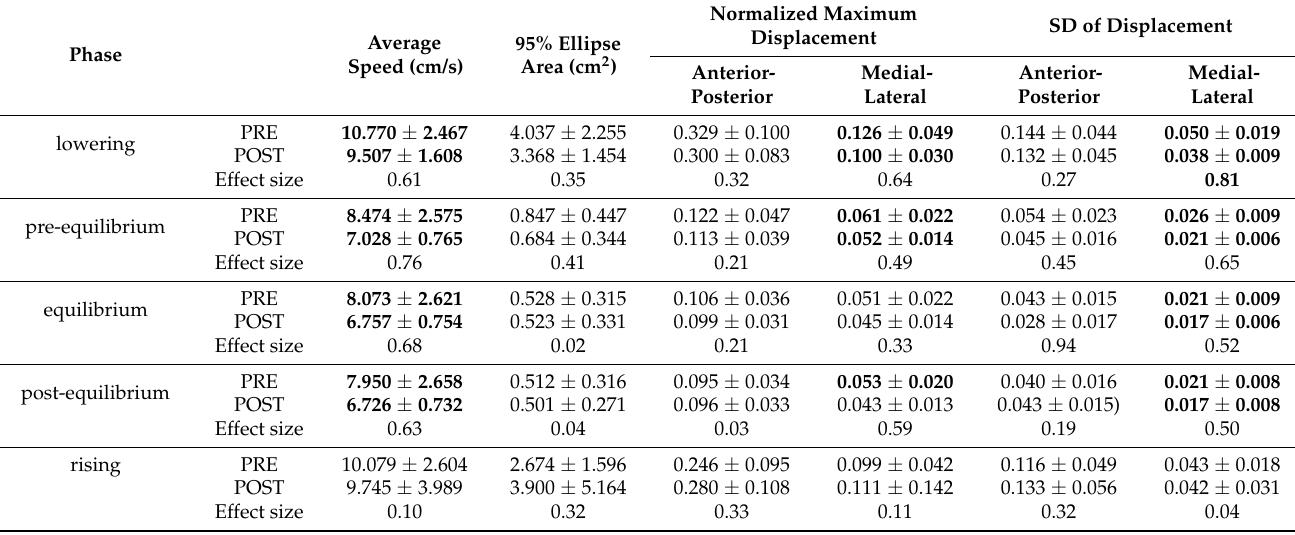
Table 5. COP parameters during grand-plie (mean ±